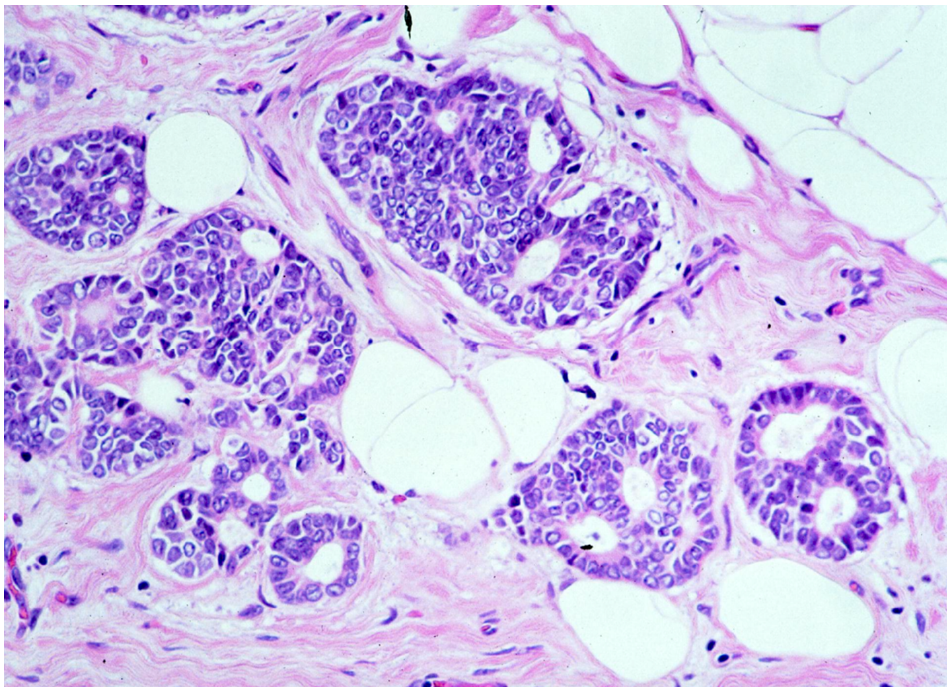
Figure 3. Ductal carcinoma in situ of intermediate nuclear grade (DIN2).